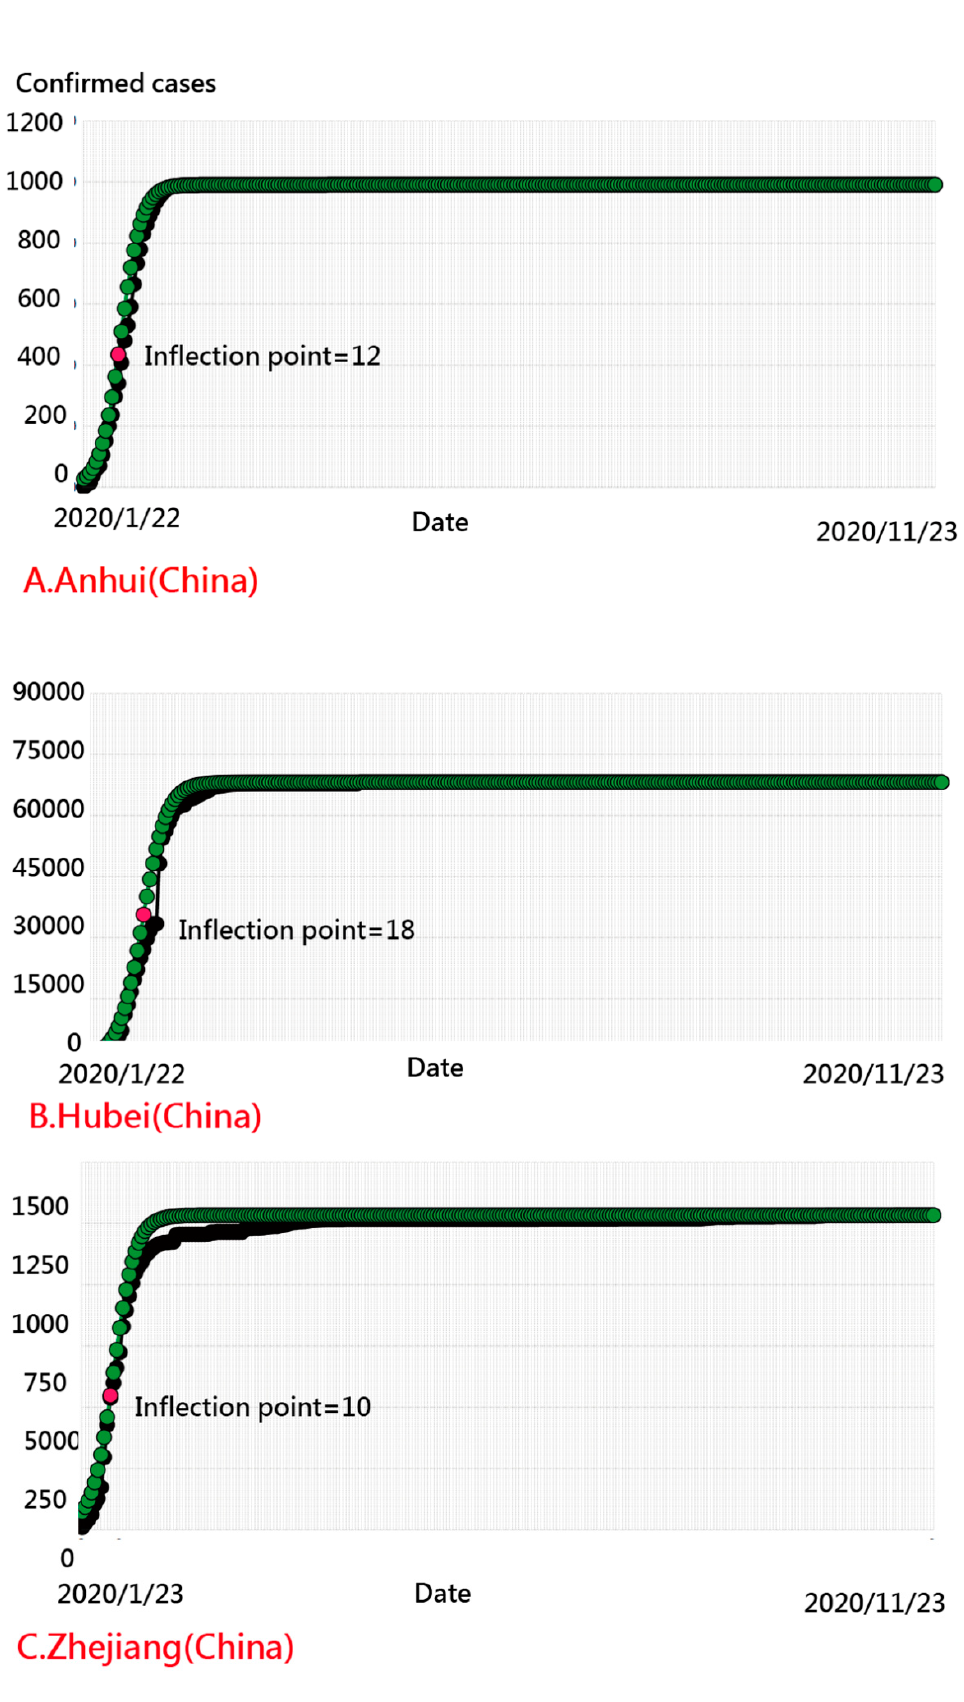
Figure 8. Regions with the best-fit curve on COVID-19 in China.